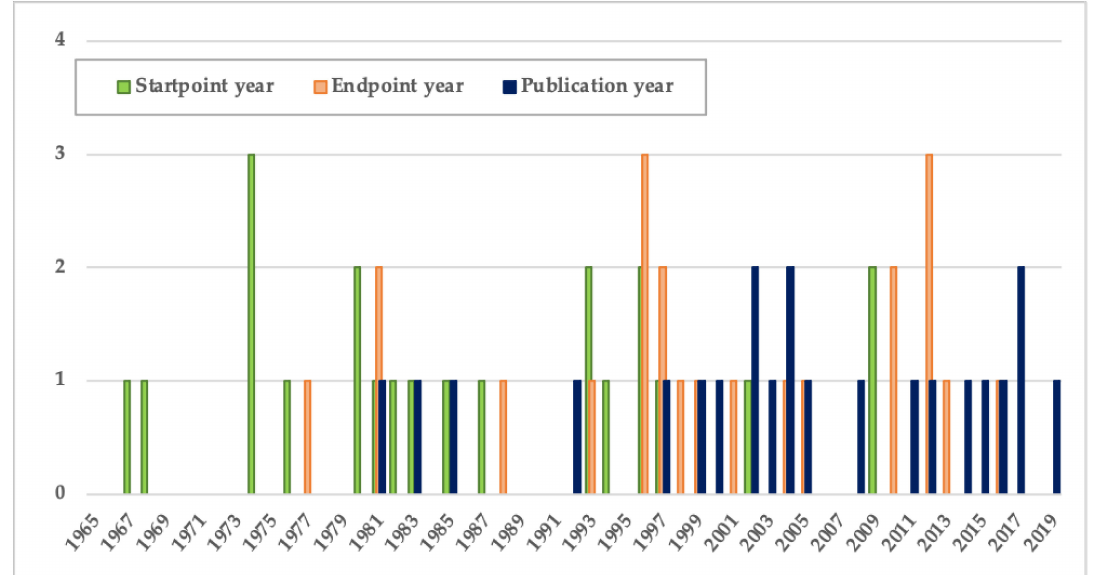
Figure 2. Number of selected studies by year of start point, endpoint, and